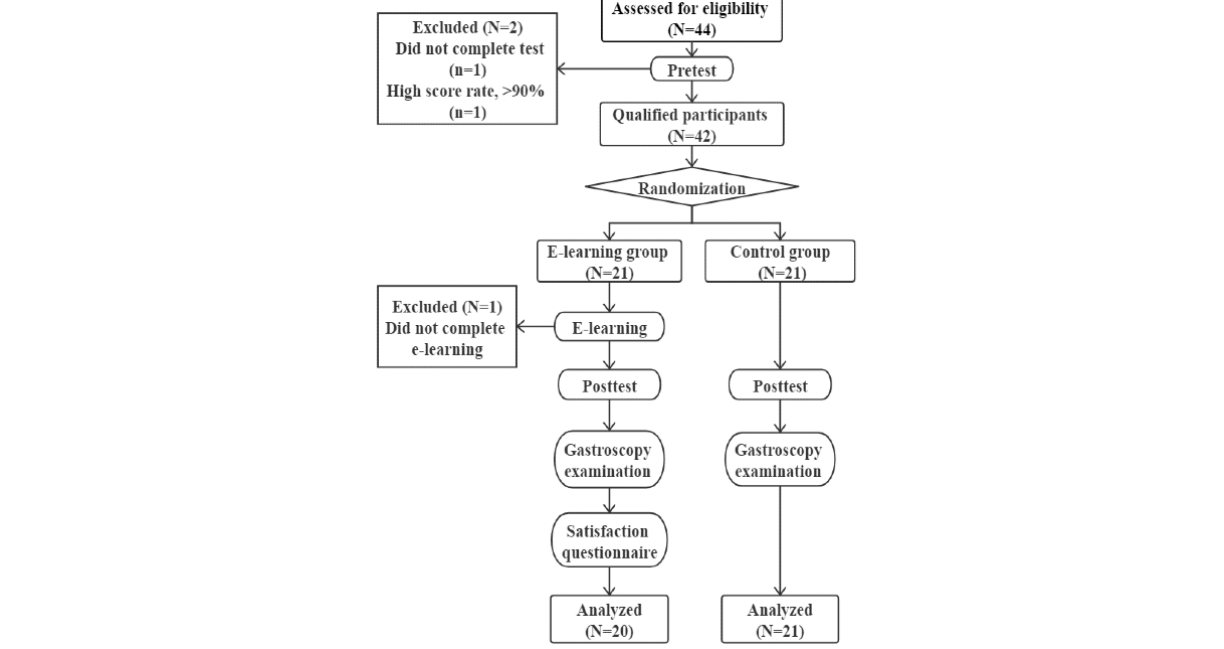
Figure 2. Flow diagram showing the details of the participant enrollment, randomization, and tests. e-learning: electronic